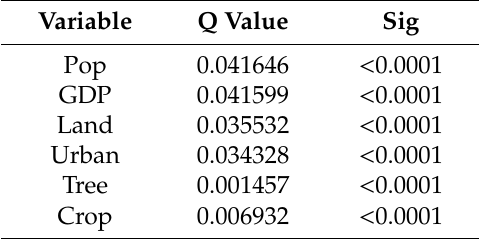
Table 1. q value in factor detection of human factors a ff ecting vegetation change in the